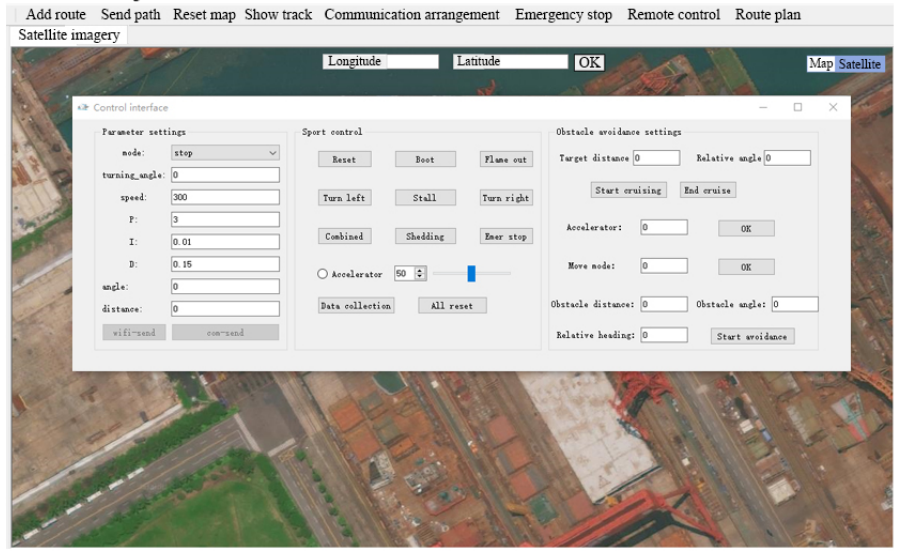
Figure 17. The control interface of the experiment platform.